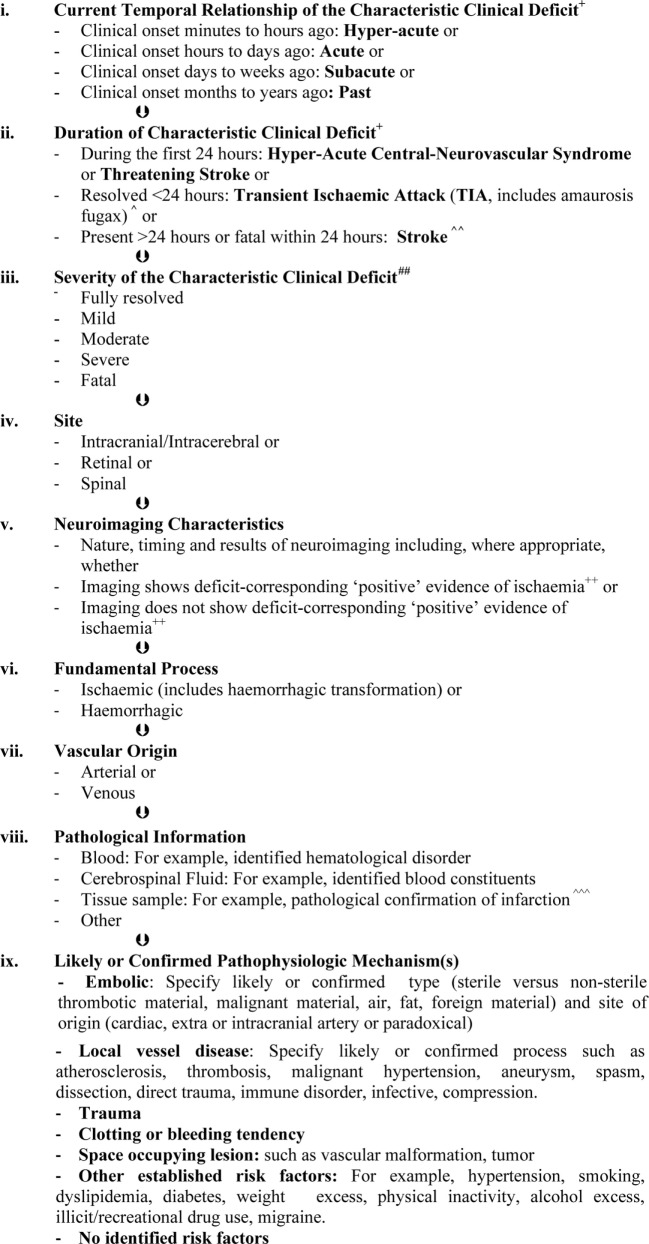
Diagnostic and classification framework for syndromes due to focal, intrinsic, central-neurovascular compromise*,**,#. *These are the sequential layers of information that should be specified as far as possible when describing syndromes due to focal, intrinsic central-neurovascular compromise. These are syndromes referable to intrinsic disorders of particular blood vessels supporting the brain, retina, or spinal cord. This classification may be expanded when there is reason. As far as possible, qualifying terms such as “likely” or “confirmed” should be included to improve clarity. **This framework recognizes that the presence of a condition does not always mean causation (124). The mechanism of stroke or transient ischemic attack (TIA) in an individual is always about assigning probabilities (0–100%). Therefore, it is more accurate to speak of risk factors and their likeliness of contributing causation. #This is a classification of clinical syndromes (symptoms and/or signs). Asymptomatic neuroimaging findings should be classified separately and according to whether or not pathological characterization has occurred. Pathologically unconfirmed asymptomatic neuroimaging findings, such as suspected asymptomatic infarcts, should be classified as such with the reasons for suspecting a particular pathology. Asymptomatic neuroimaging findings can be sub-classified using the same principles as presented in Figure 2 where relevant, when known and when there is purpose. +The most commonly recognized “characteristic” “focal” clinical deficits associated with stroke and TIA include sudden facial weakness, weakness or incoordination involving one or more limbs, dysphasia, dysarthria, visual impairment, vestibular or cranial nerve dysfunction which are manifested according to the particular vascular territory involved and neural tissue being secondarily compromised (7, 12, 13, 15). ++For computed tomography, these include hypo-attenuation relative to “normal” areas, loss of white/gray matter differentiation, focal cortical swelling, hyper-dense arterial signs, and/or compression of adjacent structures (25, 26). For magnetic resonance imaging these include diffusion-weighted, T2, and fluid attenuation inversion recovery hyperintensity (26, 39, 46). ^TIA is rapidly developed clinical symptoms and/or signs of cerebral, retinal, or spinal cord dysfunction lasting <24 h, with no apparent cause other than of focal neurovascular origin where resolution is swift and leaves no detectable permanent neurologic deficit. It is recognized that transient ischemic attacks commonly last 2–15 min. Adapted from the National Institutes of Health 1975 publication (12). ^^Stroke is rapidly developed clinical symptoms and/or signs of cerebral, retinal, or spinal cord dysfunction lasting >24 h or leading to death, with no apparent cause other than of focal neurovascular origin. It is recognized that the deficits typically appear suddenly but may progress or fluctuate (not resolving), particularly over minutes to hours after onset. Adapted from Aho et al. (7). ^^^Infarction is a pathological term used to describe tissue that has lost its blood supply for long enough to undergo ischemic necrosis (death) with characteristic macroscopic and microscopic findings (21). ##Severity may be measured according to meaningful scales such as the modified Rankin (for activities of daily living) (125). “Fully resolved, mild, moderate, severe, or fatal” should be used in preference to “disabling” versus “non-disabling” to describe severity because even mild strokes are associated with disability unless all measurable deficits have resolved.